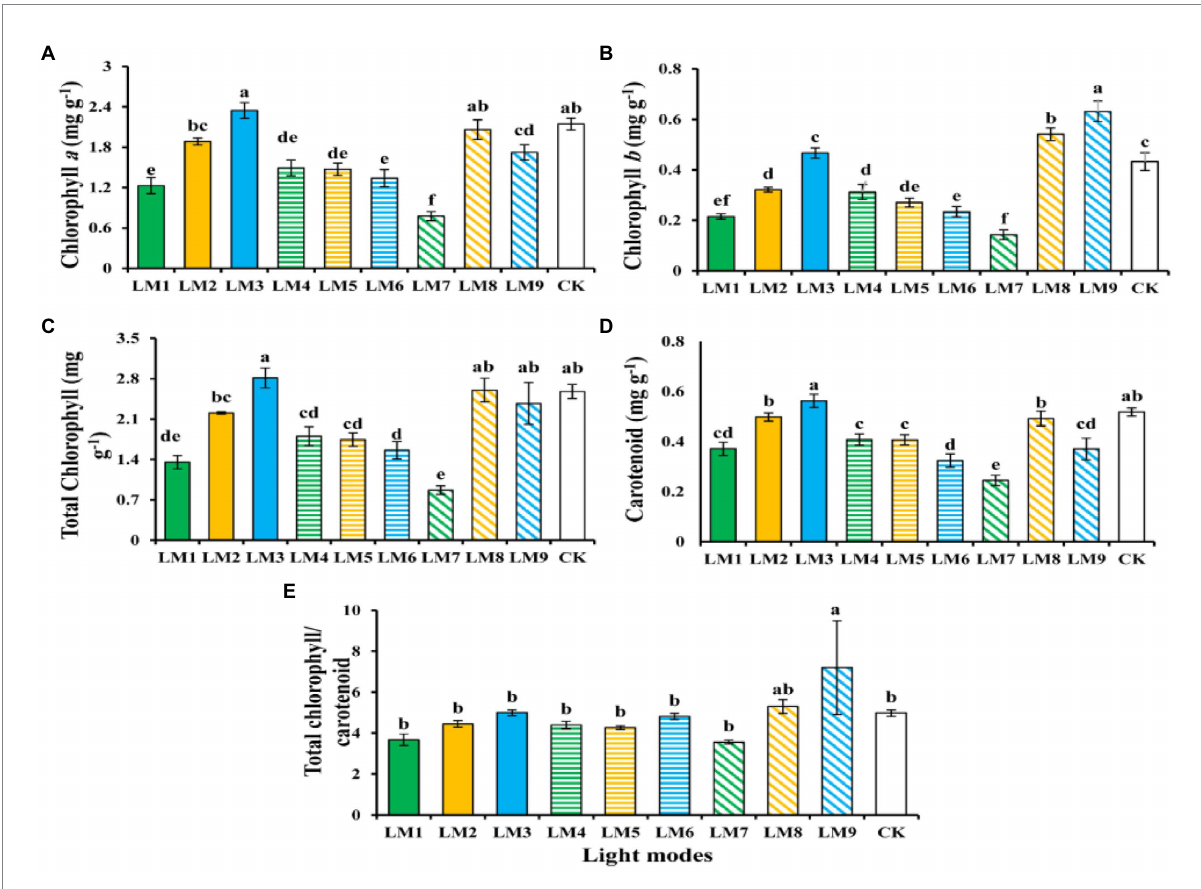
FIGURE 4 The influence of modes of LED light on the amount of photosynthetic pigments in strawberry plants [chlorophyll a (A) , chlorophyll b (B) , total chlorophyll (C) , carotenoid (D) , and total chlorophyll/carotenoid concentrations (E) ]. Each column represents the means of three technical replicates ( n = 5); the same letter within the same series is not significantly different according to Duncan’s multiple range test ( p ≤